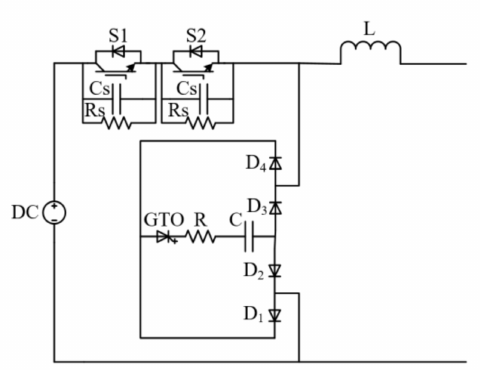
Figure 11. Configuration of the proposed solid-state DC